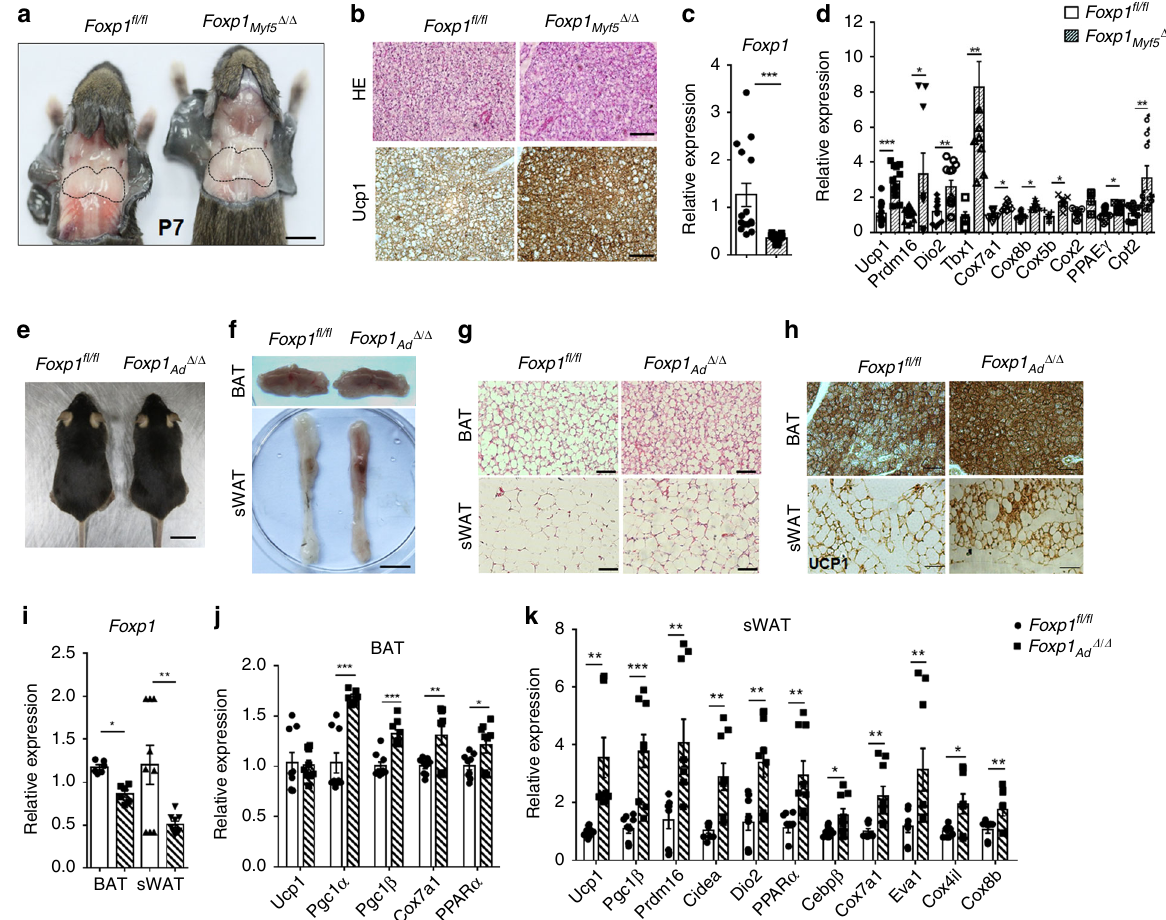
Fig. 2 Foxp1 de fi ciency promotes brown and beige adipocyte activation. a Representative dorsal view of BAT depot in Foxp1 fl / fl and Foxp1 Myf5 Δ / Δ mice at postnatal day 7. Bar, 1 cm. b HE (upper panel) and IHC staining (lower panel) with UCP1 antibody for BAT in ( a ). Bar, 10 μ m. c , d qPCR analysis of Foxp1 and BAT-selective markers for BAT depot. n = 5 biologically independent samples. e Representative view of 3-month-old Foxp1 fl / fl and Foxp1 Ad Δ / Δ mice. Bar, 2 cm. f Representative view of BAT (upper panel) and sWAT depot (lower panel) in ( e ). g HE staining for BAT and sWAT in mutant mice. Bar, 50 μ m. h IHC analysis with UCP1 antibody for BAT and sWAT upon 6-h cold exposure. Bar, 50 μ m. i – k qPCR for expression of Foxp1 and BAT-selective genes in BAT and sWAT from Foxp1 fl / fl and Foxp1 Ad Δ / Δ mutant mice. n = 4 biologically independent mice/each group. * P < 0.05; ** P < 0.01; *** P < 0.001; error bar, mean ± (Supplementary Fig. 2j) — key mediators or targets of β 3-AR signaling for lipolysis 13 . Taken with our observations in Foxp1 Myf5 Δ / Δ , Foxp1 Ad Δ / Δ and Foxp1 aP2 Δ / Δ mice, these fi ndings